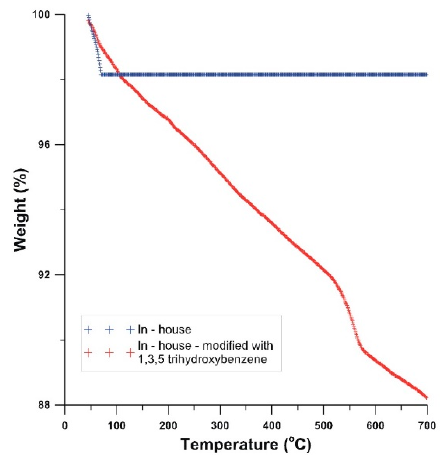
Figure 6. Thermogravimetric (TG) curve for 1,3,5-trihydroxybenzene (THB) modified in-house vs. a pristine MWCNT array sample.